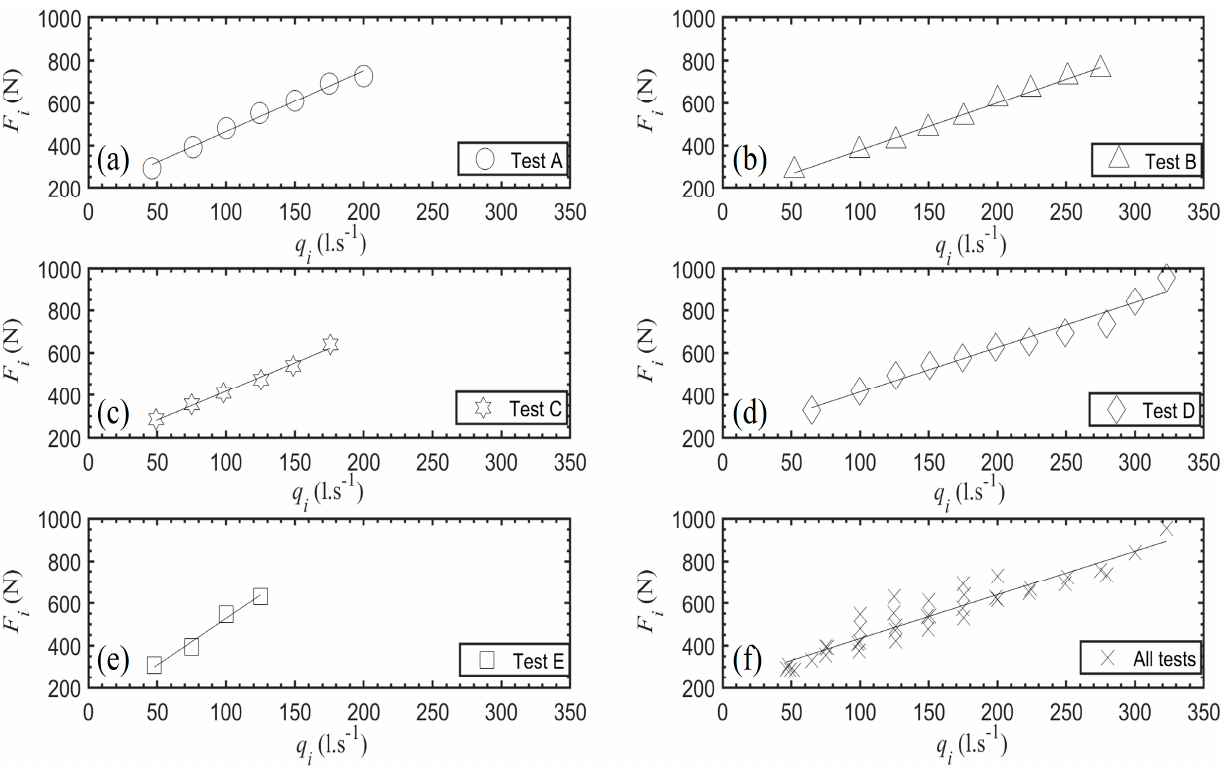
Figure 5. Example of load values ( a ) issued from test D for the six combined cells and associated discharge values ( b ) from the pumps.